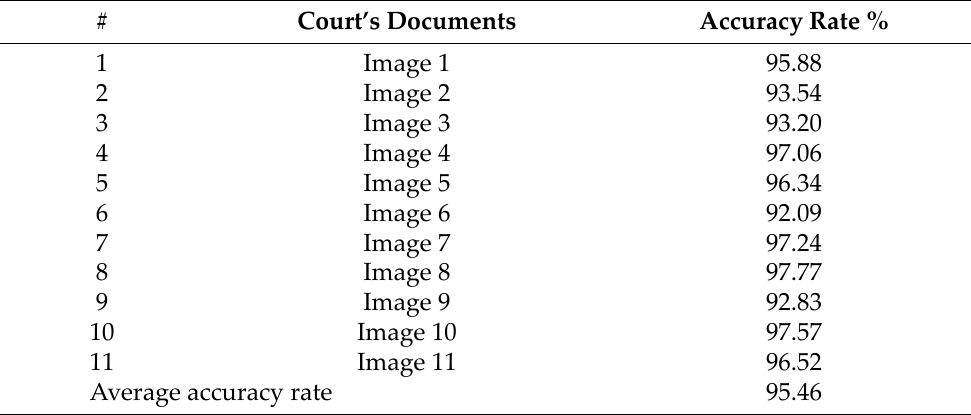
Table 13. Accuracy rate for court’s document images using